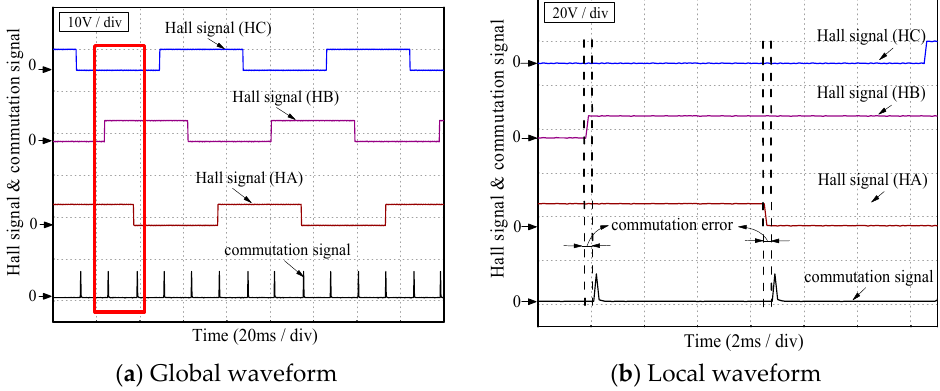
Figure 25. Waveforms of the commutation signal and Hall signals (300 r/min).